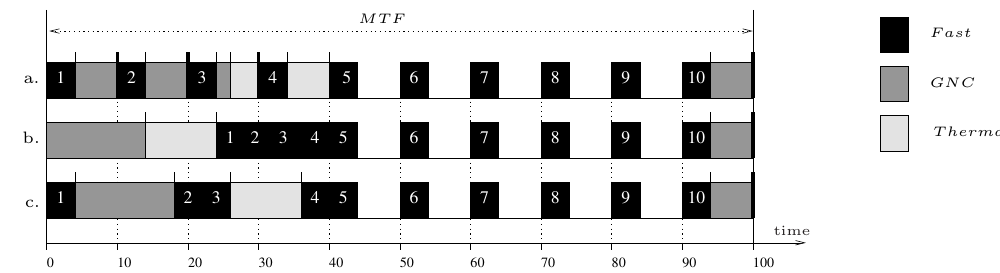
Figure 10 Scheduling result for the examples in Figures 7, 8, and 9 on a single-processor architecture (a). The result of applying the post-scheduling slot optimization of Section 7 for the example in Figure 7 (b) and for the example in Figures 8 and 9 (c).